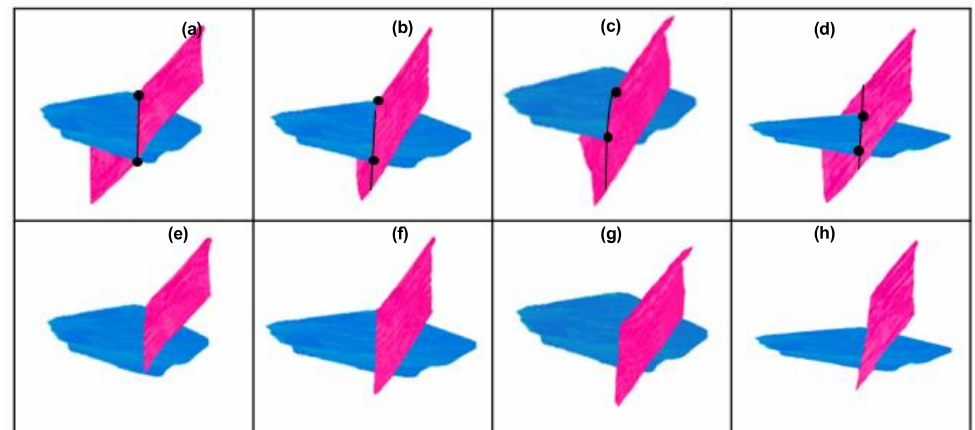
Figure 7. Schematic diagram of truncation rules. The ( a ) has an intersection line that directly cuts across the two faults surface, and the fault surface of ( b – d ) are all partially cut across. Usually, the smaller spread part is truncated. The truncated results are showed in ( e – h ). The red fault partially extends over the blue fault surface in ( b – d ), which may exist in practice, so we maintain these parts as they used to be.